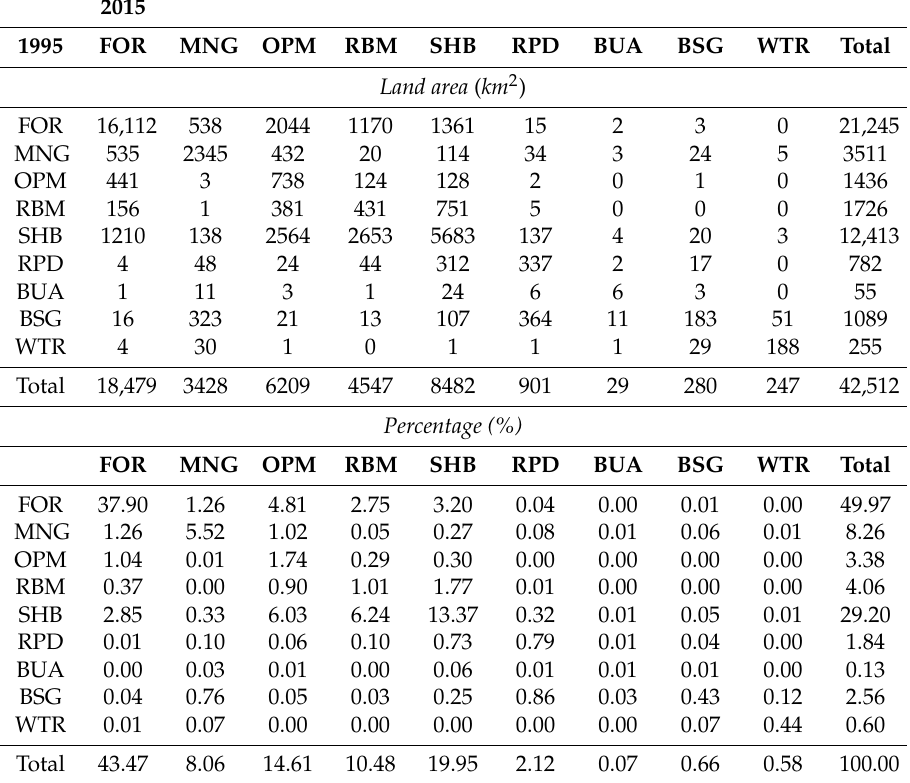
Table 8. Land cover change matrix from 1995 (rows) to 2015 (columns) based on Landsat + SAR data showing land area (km 2 ) and percentage of total area (%) of land cover classes in Tanintharyi Region, Myanmar.